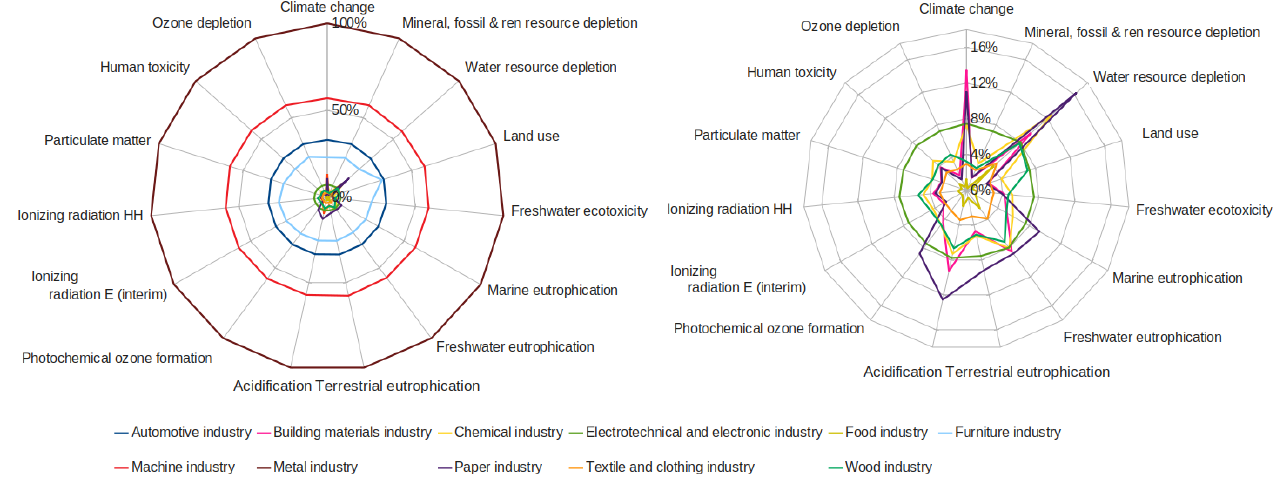
Figure 2. Environmental profiles of manufacturing in Poland.